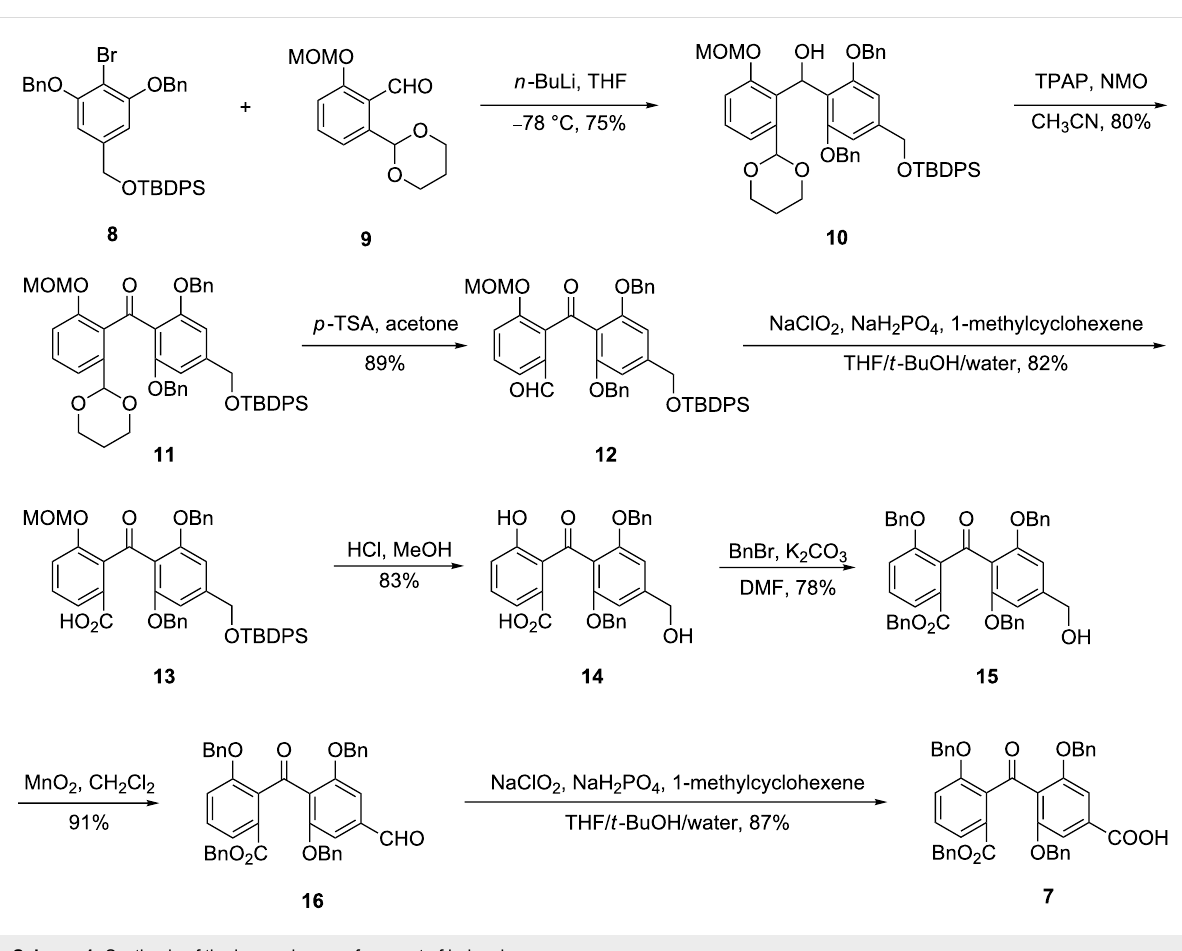
Scheme 1: Synthesis of the benzophenone fragment of